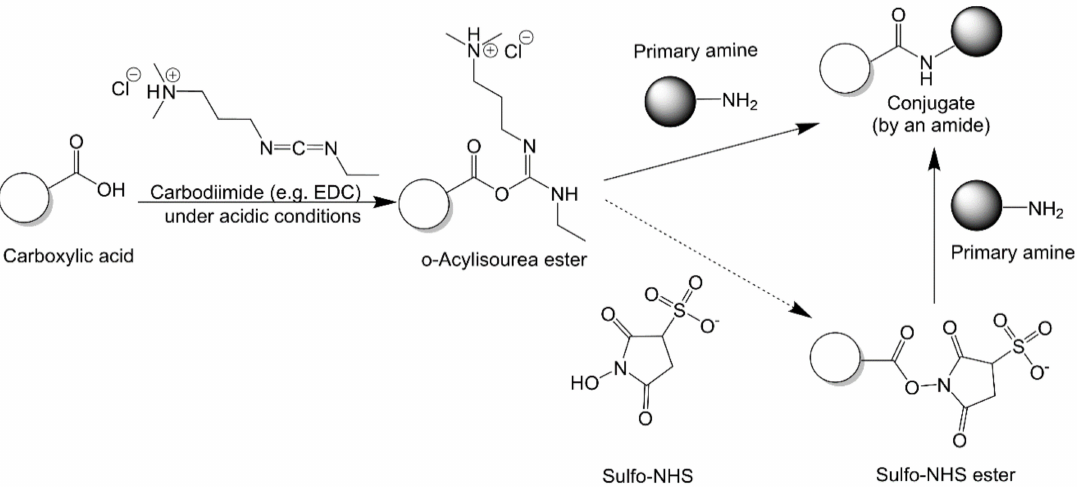
Figure 5. Carbodiimide chemistry. This conjugation reaction can be performed with or without the help of NHS (for example, with the use of the water-soluble derivative of NHS, sulfo-NHS).